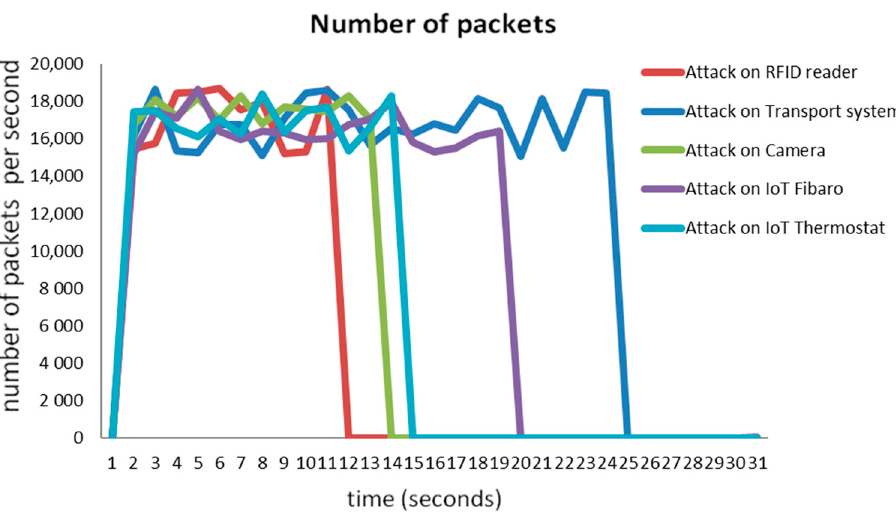
Scheme 4. Scenario 4 — communication